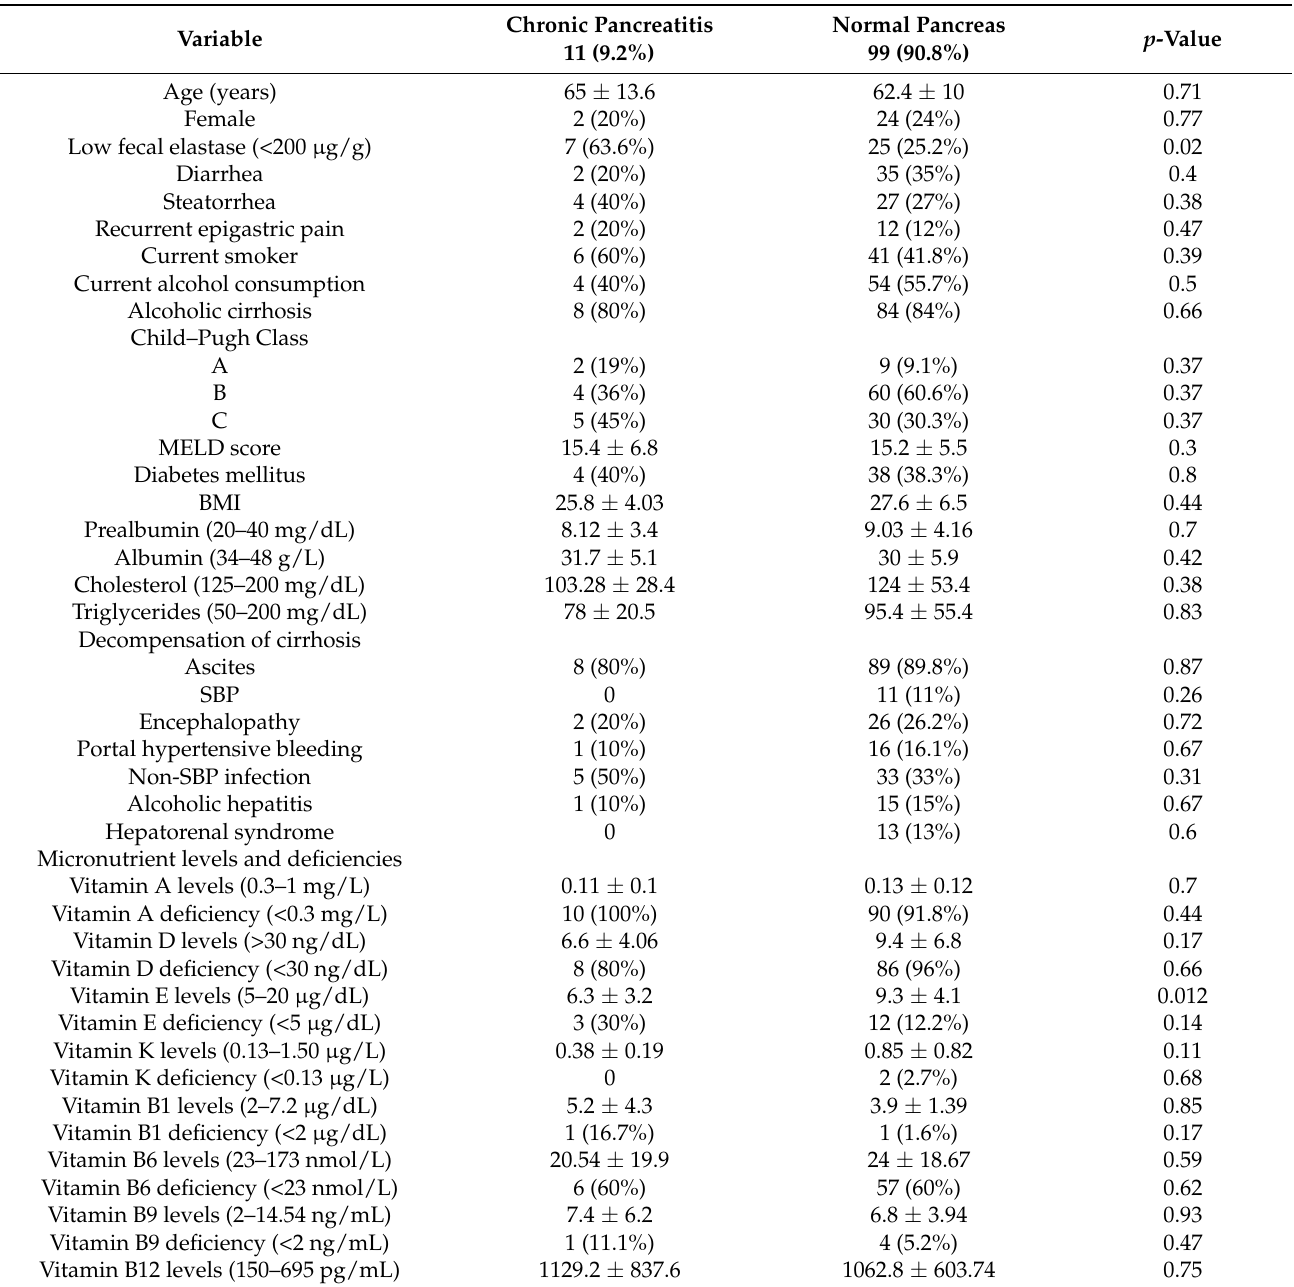
Table 2. Chronic radiological pancreatitis vs. normal pancreas ( n =